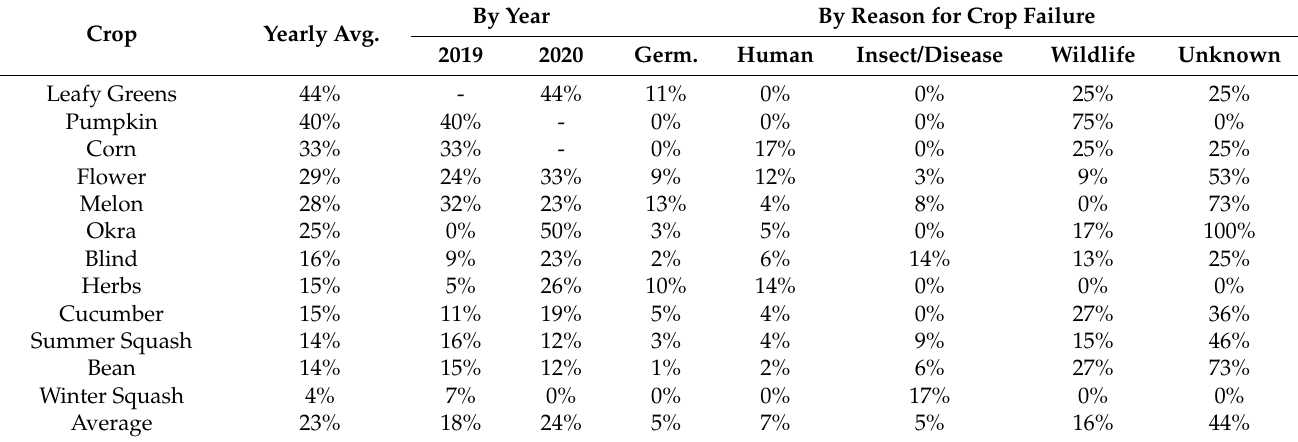
Table 4. Crop failure rate (self-reported) by crop by year from 2019 to 2020 and by reason for crop failure (self-reported). Data are presented in descending order from the highest yearly average data failure rate. Crops that do not have data for a specific year were not offered as trials in that year. Data are not presented for youth trials, as these were for outreach purposes, and data was not collected for trials offered only in years before